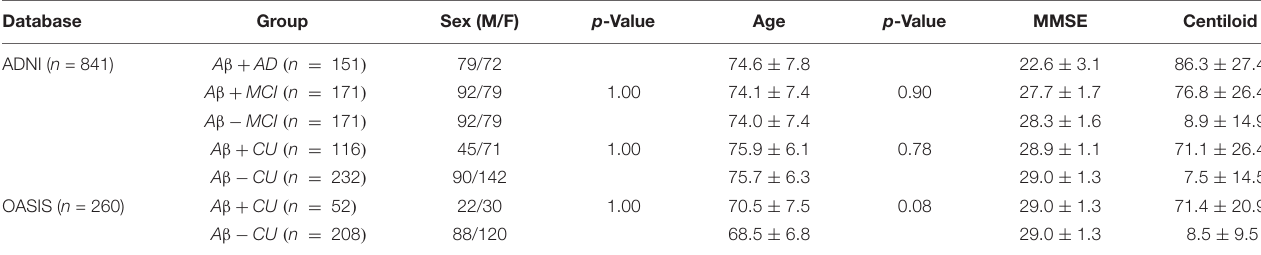
TABLE 1 | Demographic information for the subjects we study from the ADNI and OASIS cohorts.